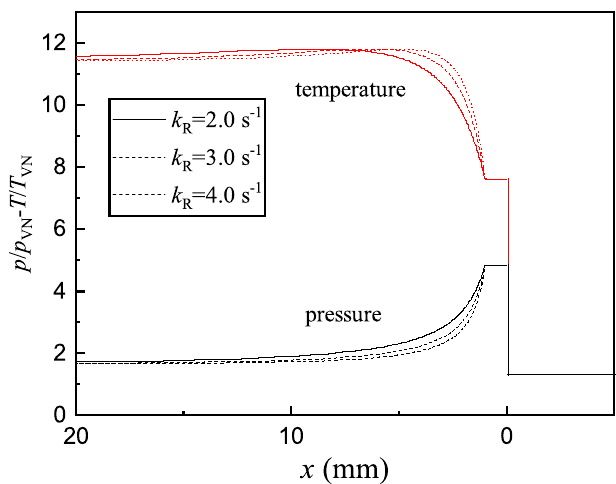
Figure 1. Steady structures of ZND detonations with different instability